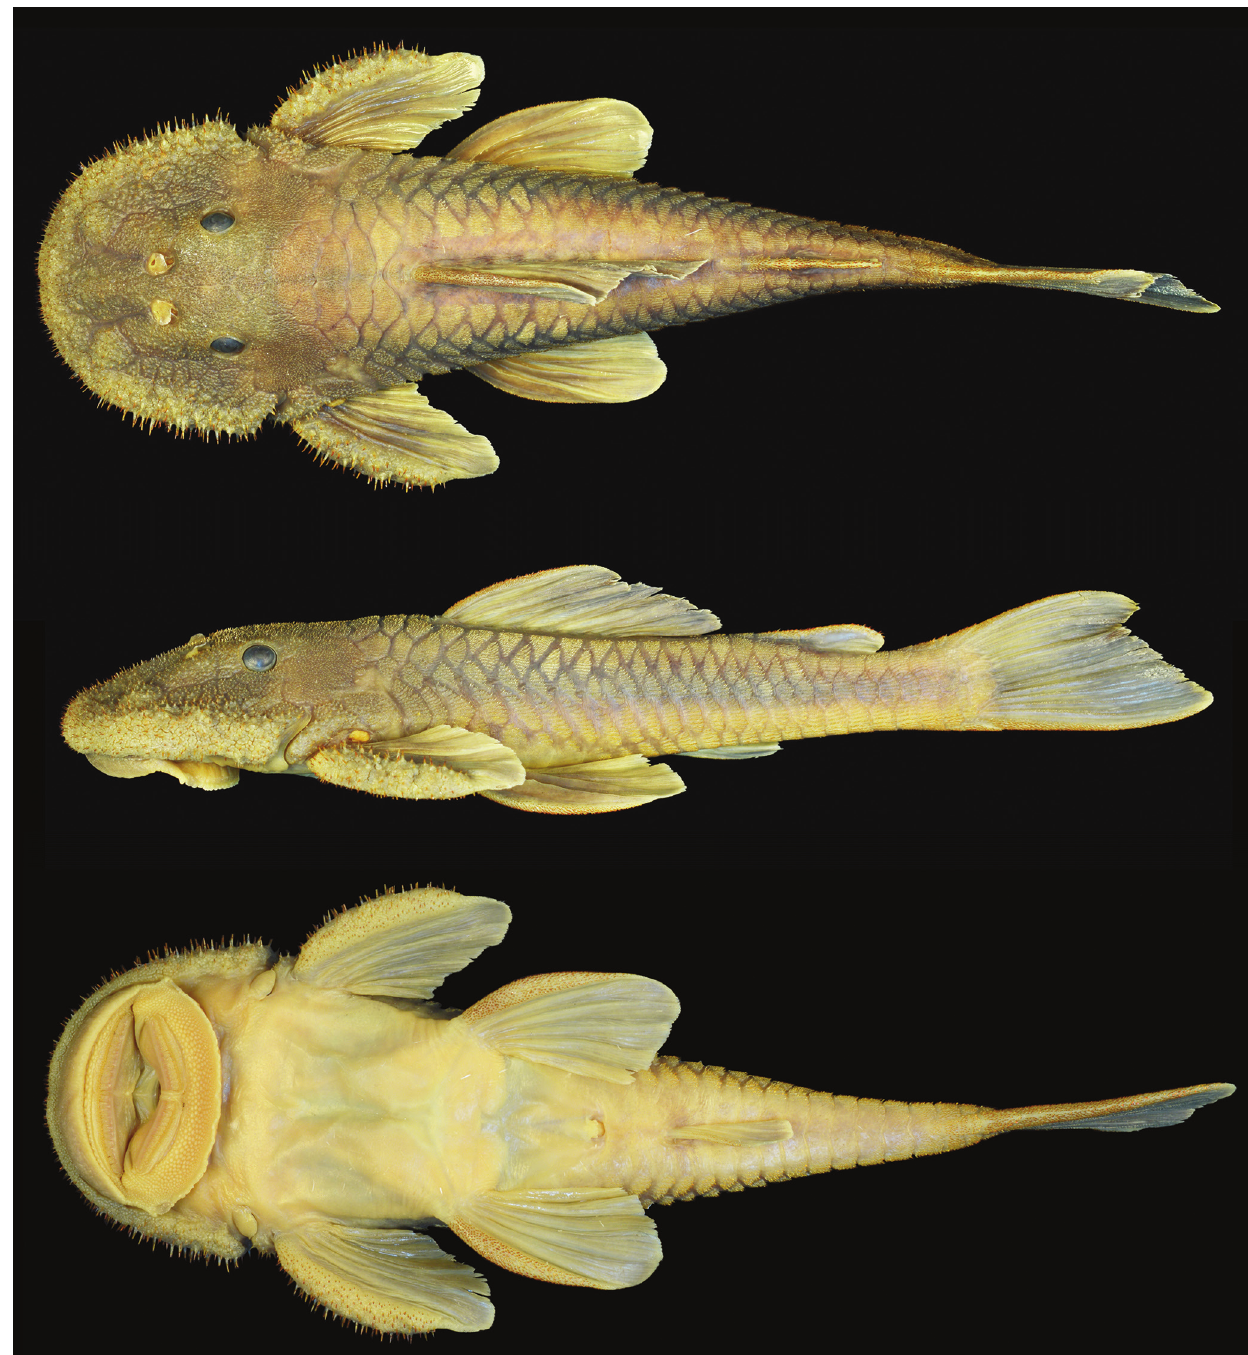
Fig. 1. Pareiorhaphis lineata , MCP 50863, holotype, 95.1 mm SL, Brazil, Minas Gerais State, Grão Mogol, rio Jequitinhonha basin, rio